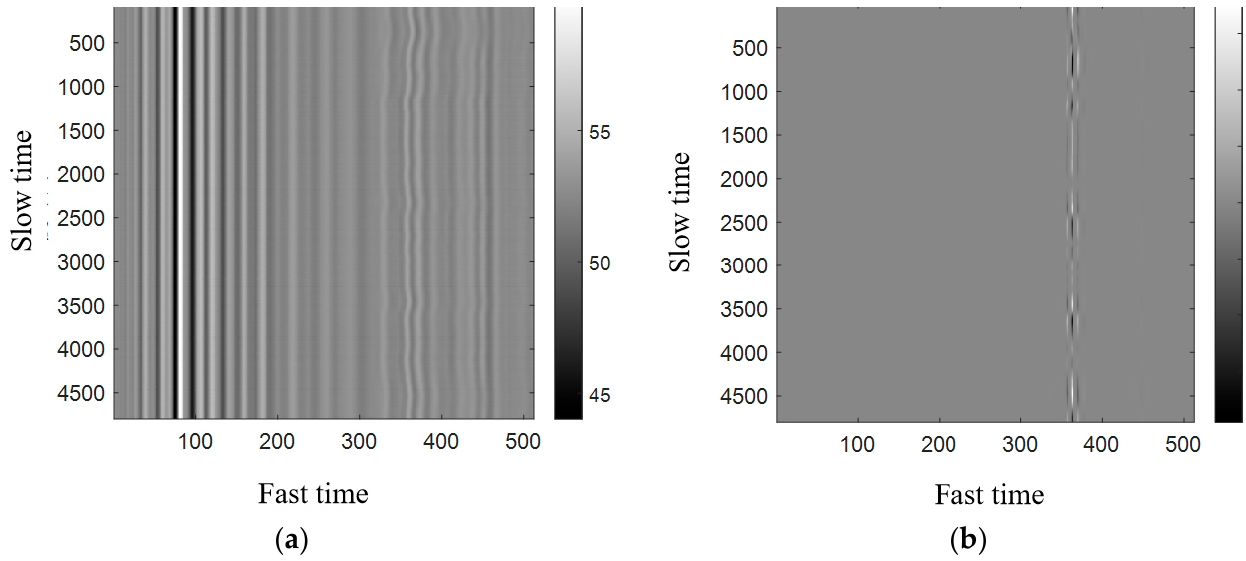
Figure 2. Comparison of grayscale maps before and after preprocessing. ( a ) Grayscale map before preprocessing. ( b ) Grayscale map after preprocessing.